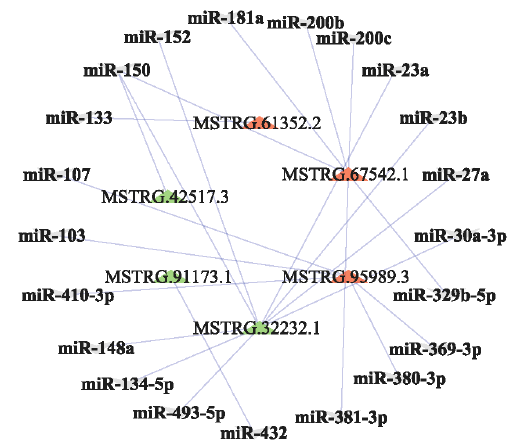
Figure 3. The lncRNA-miRNA interaction network. The red and green triangles represent up-regulated and down-regulated lncRNAs in the mammary gland of STH ewes compared with the mammary gland of GAM ewes, respectively. The gray inverted triangles represent the predicted target miRNA sponges of lncRNAs.